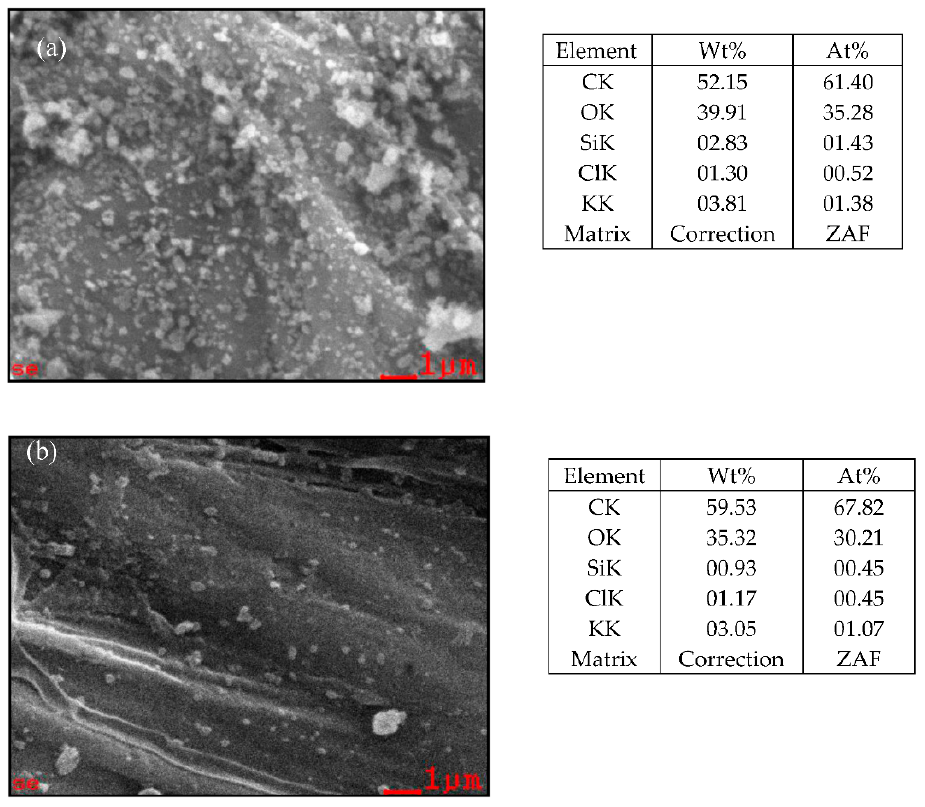
Figure 19. SEM-EDX mapping of coated bamboo: ( a ) n-hexane, TMCS (13%), silica (0.5%) with 129.5° contact angle; ( b ) iso-octane, TMCS (13%), silica (0.5%) with 79° contact angle.